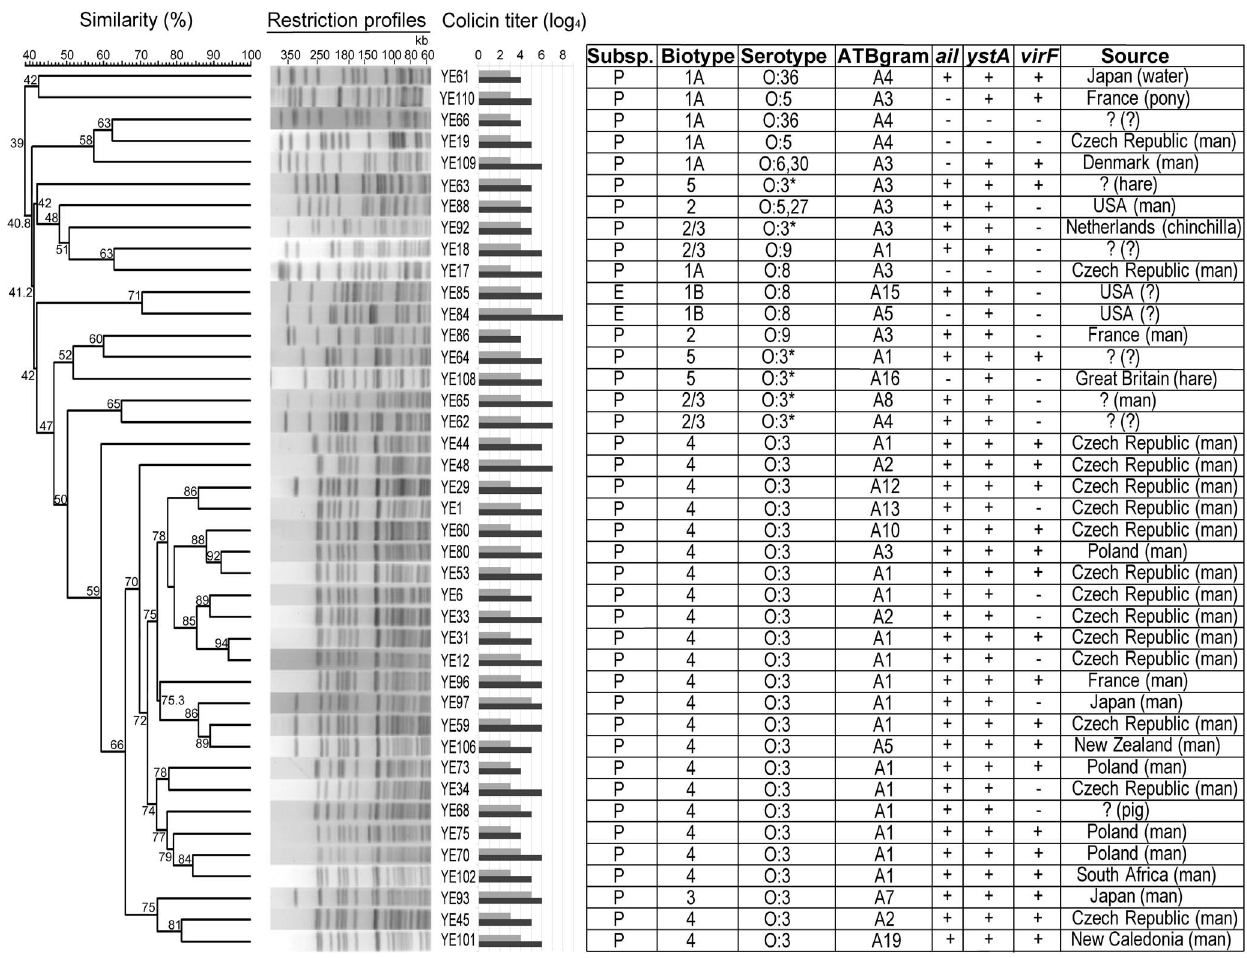
Figure 1. Identified pulsotypes among Y.enterocolitica isolates. Similarities (%) between restriction patterns were calculated using the Dice’s index and are shown as the numbers close to nodes. The data were sorted using the UPGMA method. For construction of this dendrogram, 41 Y. enterocolitica pulsotypes with similarity lower than 85% were selected from a dendrogram containing all 110 isolates (Fig. S1). Susceptibility to colicin F Y is shown in the right panel, followed by additional strain characteristics. Colicin F Y titers are shown as the reciprocal exponent of the highest four- fold dilution causing clear (light grey) and turbid (dark grey) zones of inhibition. Subspecies: P= palearctica , E= enterocolitica . *Serotypes O:1 and O:2 have been combined to O:3 serotype according to [1].